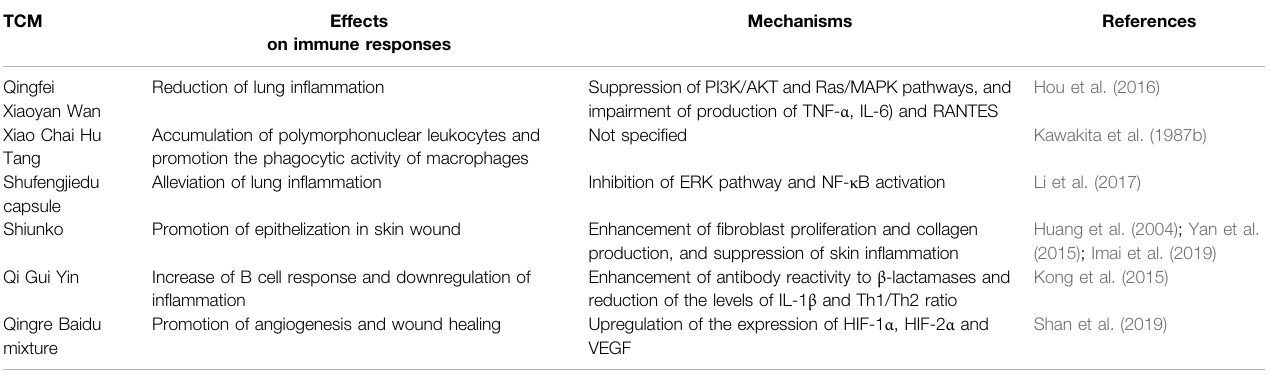
TABLE 5 | Summaries of TCM-modulated host immune responses during P. aeruginosa